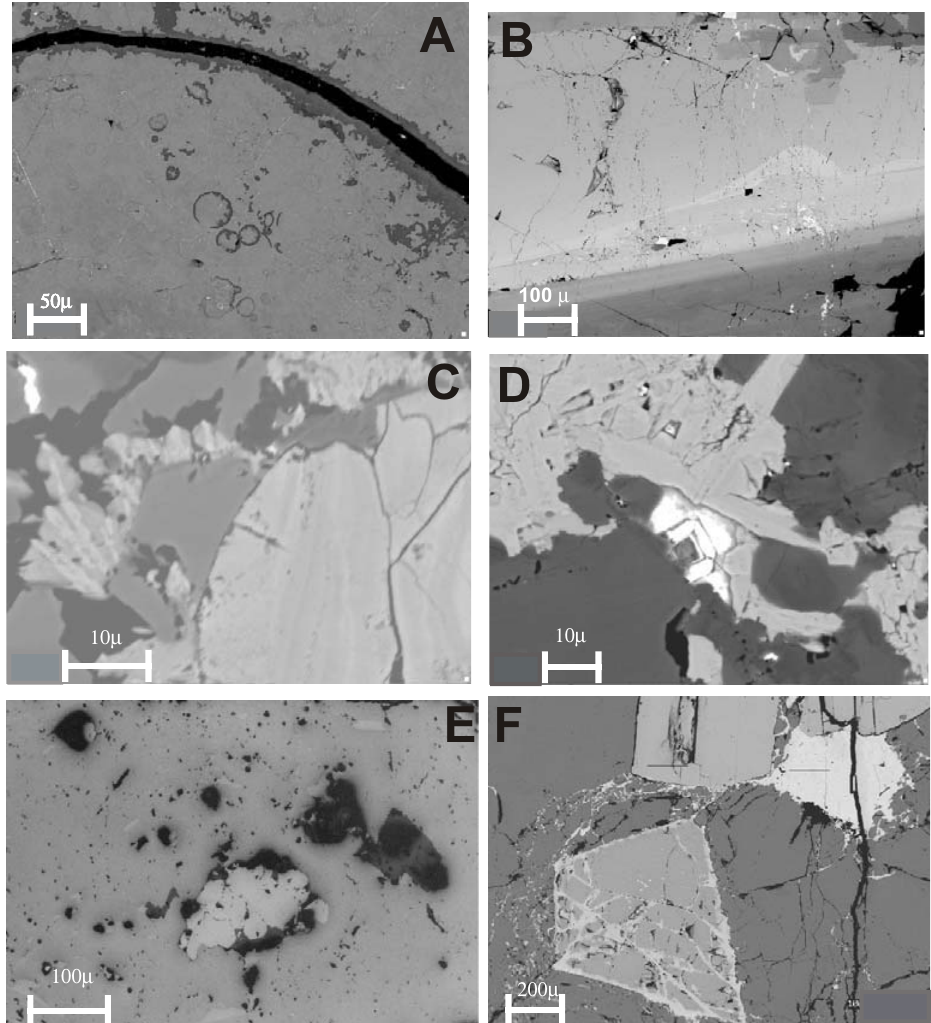
Fig. 3 – Backscanned SEM images: A) Brannerite showing the metamictic, collomorphic like micro-texture and gradual changes in ‘‘reflectivity’’ and composition. B) Titanian ixiolite crystal showing oscillatory compositional zoning with dark Ti-Nb-rich rims (top and bottom of the image) and Ta-Nb-rich, light, core. The small bright grains along fractures are microlite, pyrochlore and Ca-Ti- columbite. C) Light gray zoned Ca- Ti-bearing columbite inclusion with rounded contours, in the right side of the image, and a radial aggregateoftabularCa-Ticolumbitewithslightlydarkerovergrowthsoffersmiteinafractureoftitanianixiolite(darkgray). Thewhite, fracture filling grain in the top left corner, is uranopyrochlore. D) The light gray/gray zoned cubic crystal in the center of the image is of uranmicrolite (white) and microlite (gray). The tabular gray crystal aggregate immediately above, is Ca-Ti-bearing columbite with slightly darker overgrowths, and interstitial fersmite, altogether filling a fracture in the dark titanian ixiolite. E) Cassiterite with small, slightly brighter ferrowodginite exsolutions and, in the center of the image, inclusion of a polygonal aggregate of light gray strüverite crystals. F) Simpsonite (dark gray matrix) with an idiomorphic inclusion of F-Na microlite (gray, in the center) and of tabular manganotantalite crystals in the top. The light gray mass enveloping the manganotantantalite is of microlite, with compositions ranging from stibio- to plumbomicrolite. The borders and cleavages of the microlite crystal are replaced by bario- (or parabario-) microlite (slightly darker gray hue than Pb- and